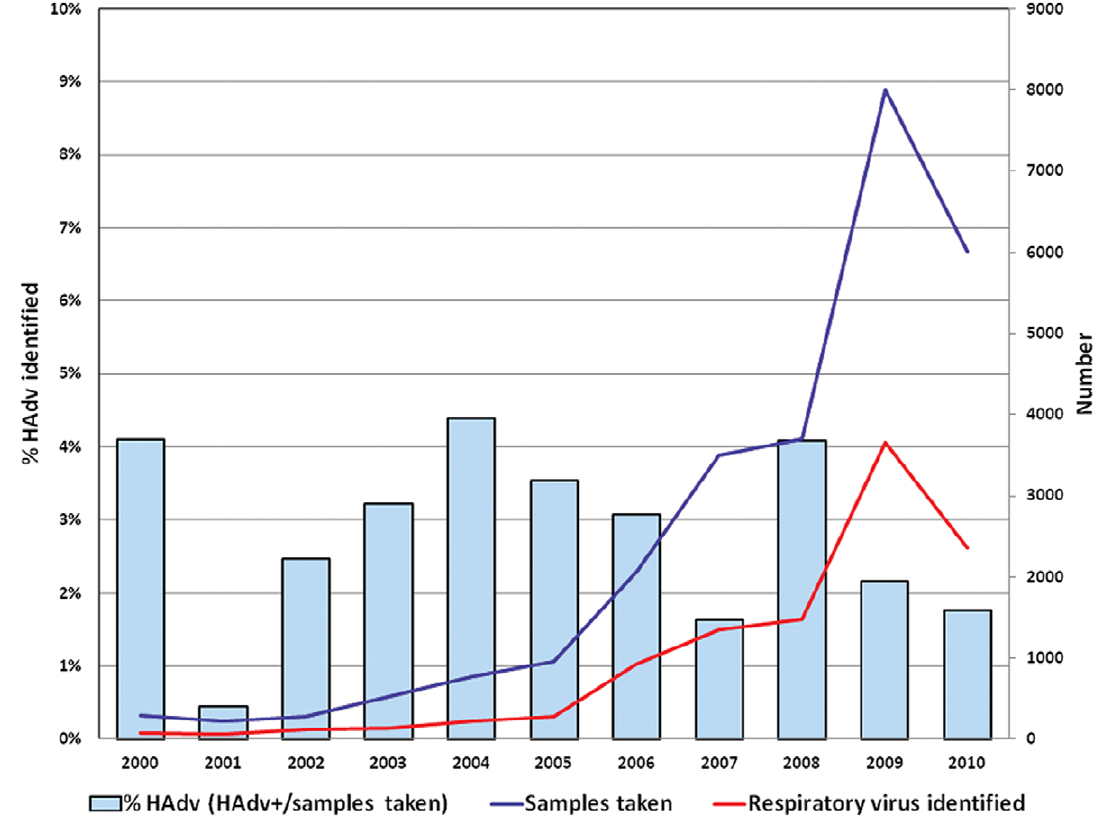
Figure 2. Samples collected, samples with a respiratory virus identified, and proportion of samples with HAdv identified by year. Peru, 2000–2010.